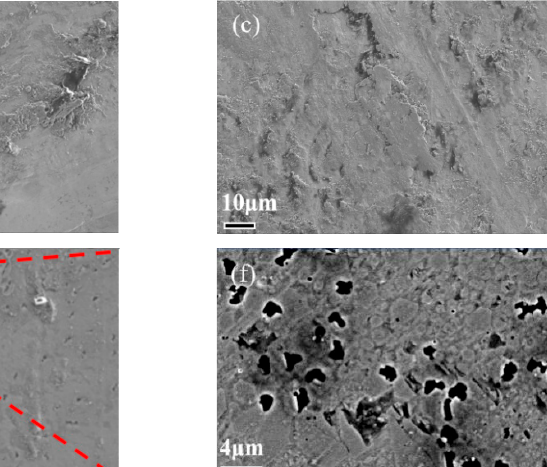
Figure 9. SEM morphology of grinding pin surfaces prepared using the same process and different Cr 3 C 2 content: ( a ) 0 wt.%, ( b ) 5 wt.%, ( c ) 15 wt.%, ( d ) 25 wt.%, and ( e , f ) 35 wt.%.